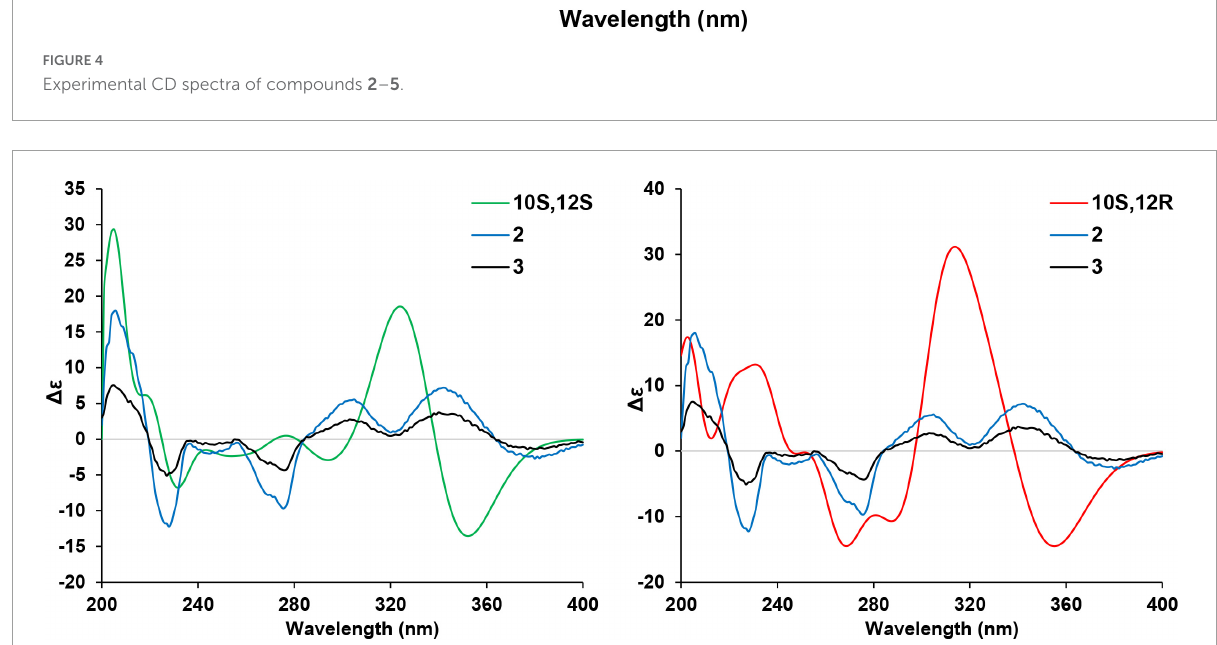
FIGURE5 Comparison of the calculated electronic circular dichroism (ECD) of (10 S ,12 S )- and (10 S ,12 R )-isomers vs. compounds 2 and 3